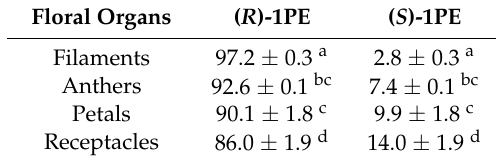
Table 1. Ratios of ( R )- to ( S )-1PE in the endogenous 1PE in different floral organs. Floral Organs